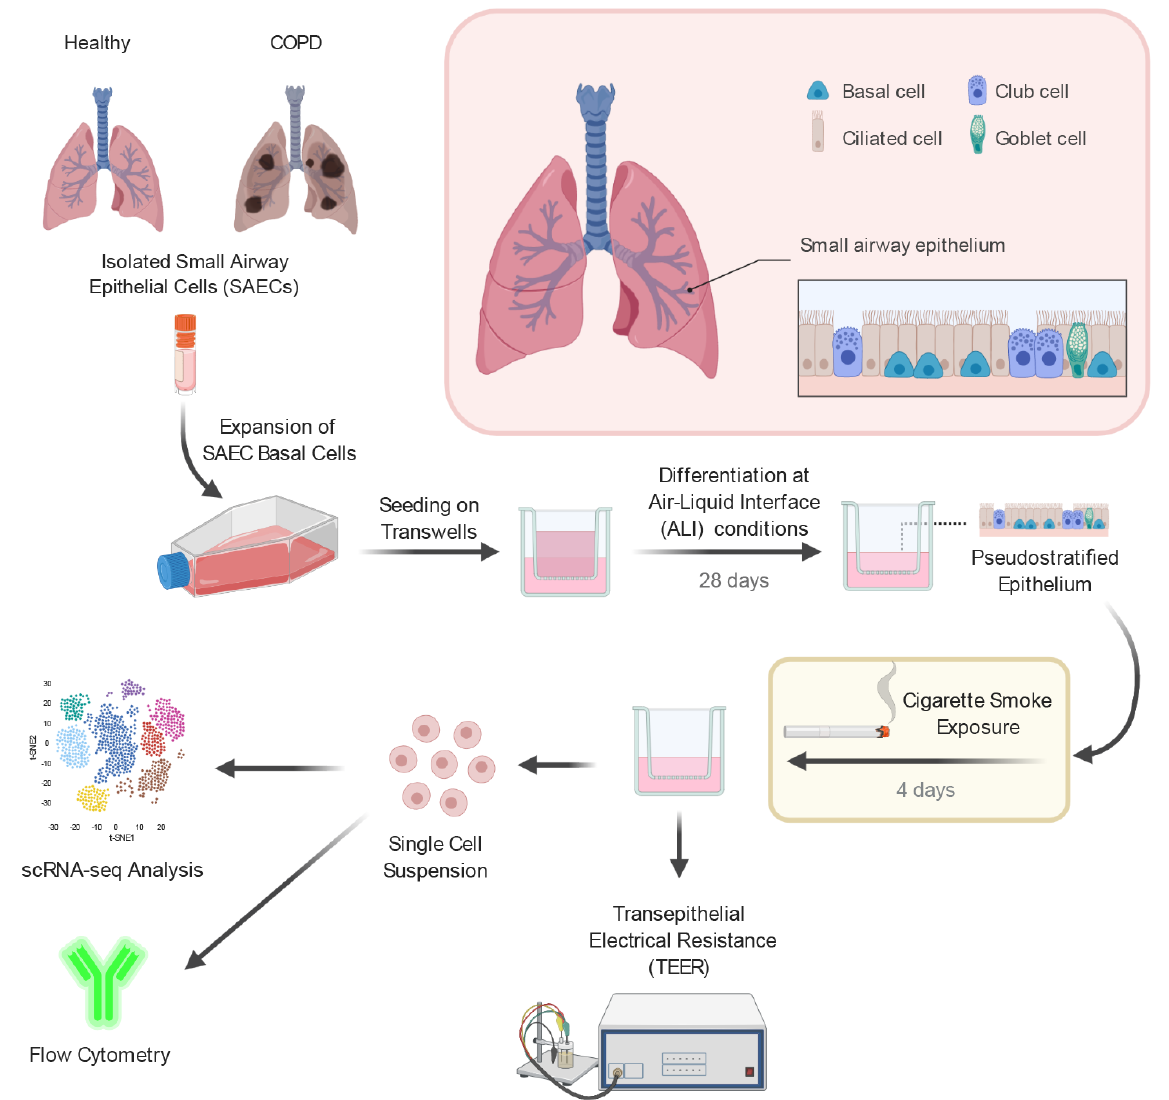
Figure 1. Experimental design to investigate the impact of acute smoke exposure on small airway epithelial cells. Basal cells from primary small airway epithelial cells (SAECs) isolated from lungs of healthy controls ( n = 3) and chronic obstructive pulmonary disease (COPD) patients ( n = 3) were expanded in vitro and differentiated on air–liquid interface (ALI) conditions into a pseudostratified epithelium. Characterization and investigation of acute cigarette smoke exposure (4 days) on the different SAEC populations were performed by single-cell RNA-sequencing (scRNA-seq), flow cytometry and transepithelial electrical resistance measurement.